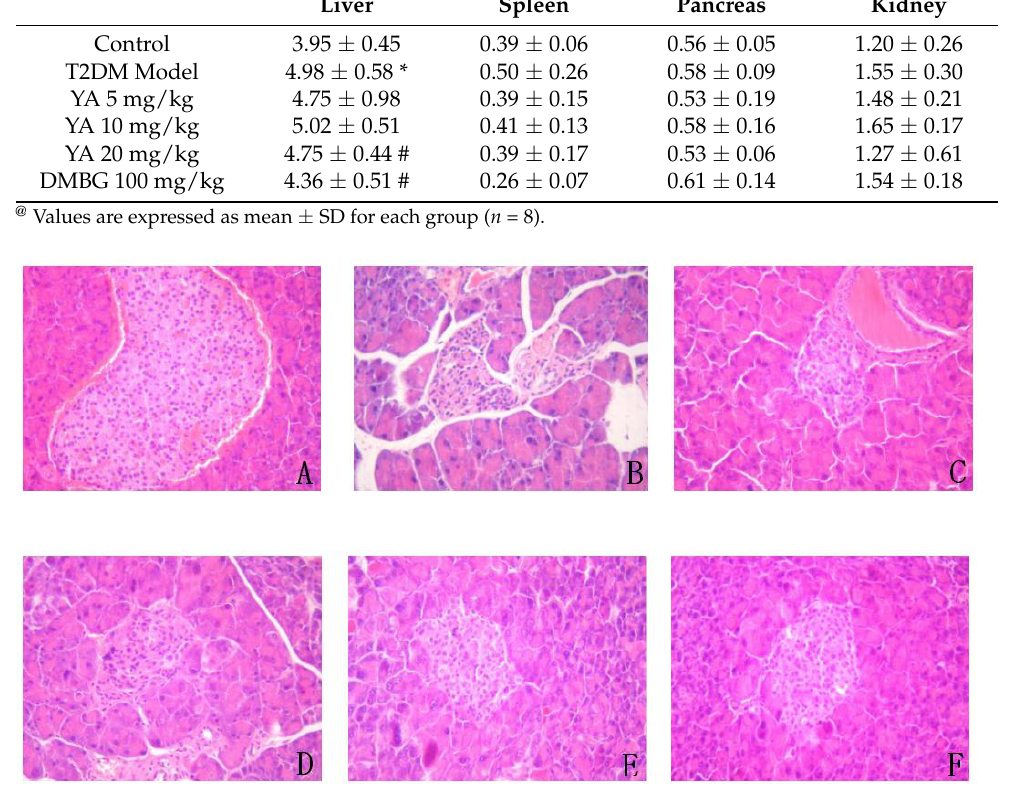
Figure 9. Representative hematoxylin and eosin (H&E) staining sections of pancreases from mice in the different groups (×200). ( A ). control; ( B ). T2DM mice; ( C ). YA 5 mg/mL; ( D ). YA 10 mg/mL; ( E ). YA 20 mg/mL; ( F ). DMBG 100 mg/mL.